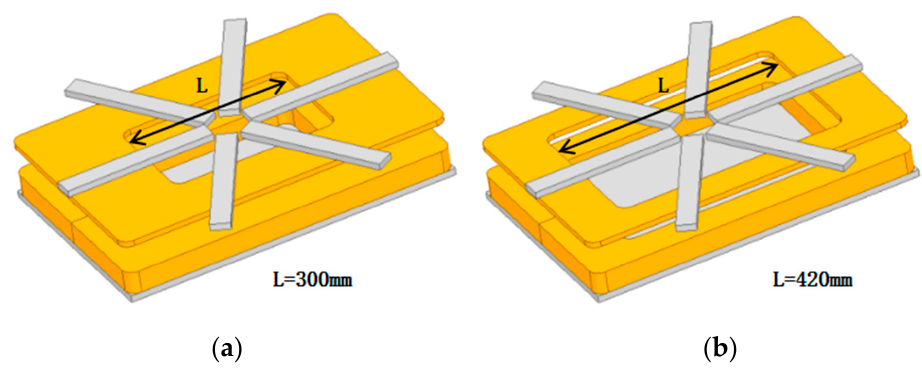
Figure 8. Hole sizes optimization simulation model: ( a ) L = 300 mm, ( b ) L = 420 mm.